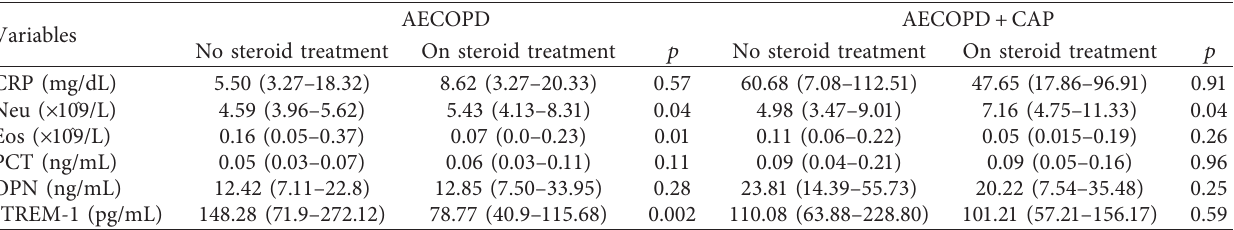
Table 7: The levels of CRP, PCT, Neu, EOS, sTREM-1, and OPN in patients with AECOPD/AECOPD +CAP according to the current use of SCS.